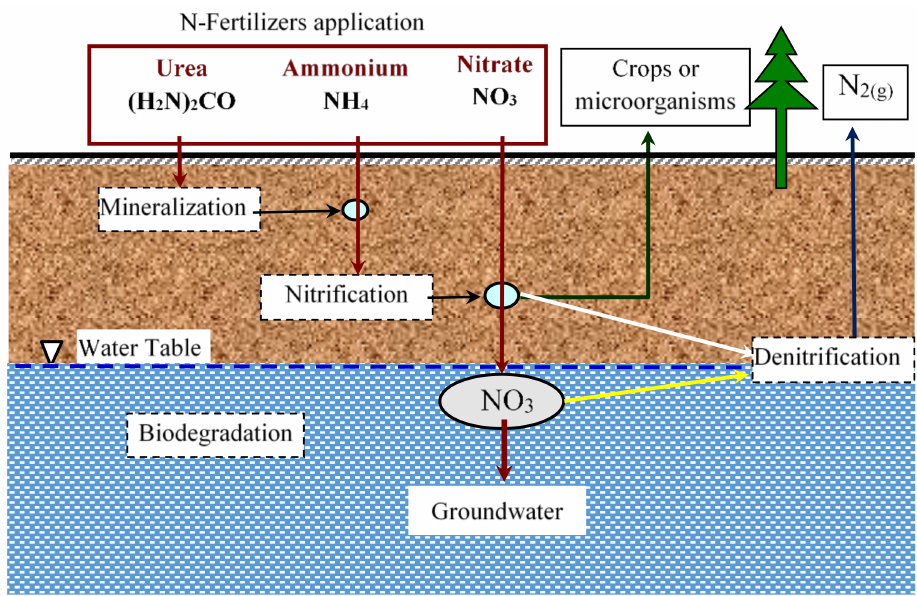
Figure 1. N-fertilizers and transformation of nitrate in the subsurface (modified from Shamrukh